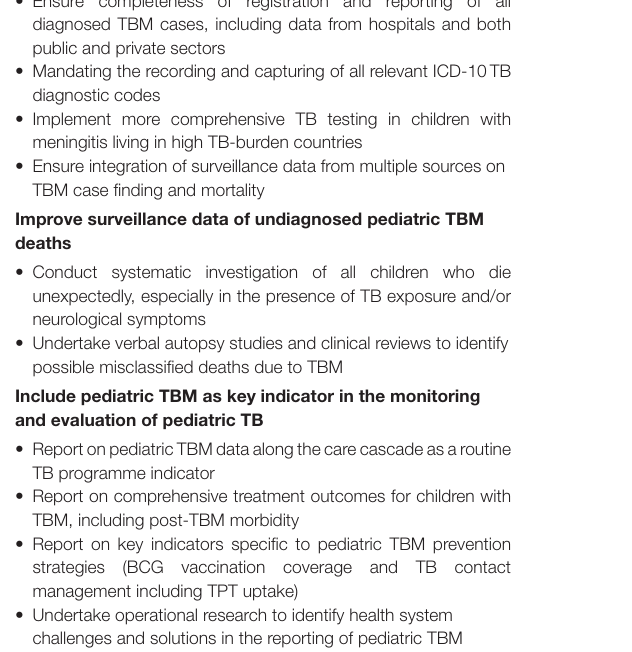
TABLE 1 | Practical recommendations to strengthen pediatric TBM surveillance. Strengthen routine surveillance of children diagnosed with